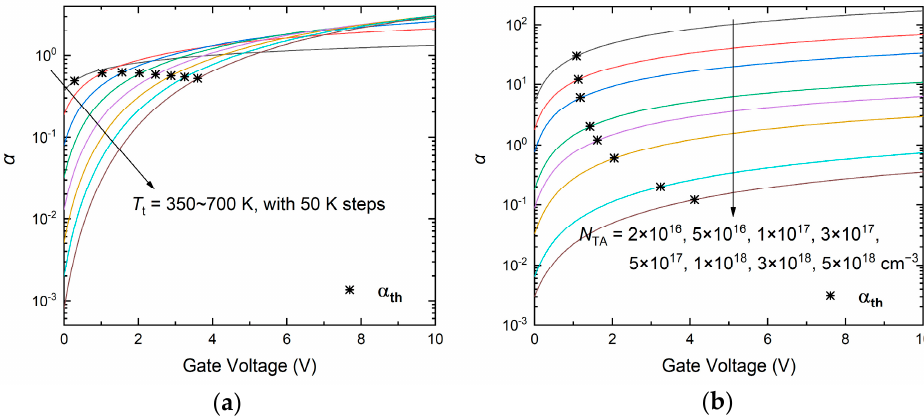
Figure 2. Variations of α with gate voltage under various ( a ) T t ( N TA = 1 × 10 18 cm − 3 ) and ( b ) N TA ( T = 500 K), and α th demotes the threshold conditions, with parameters displayed in Table 1.